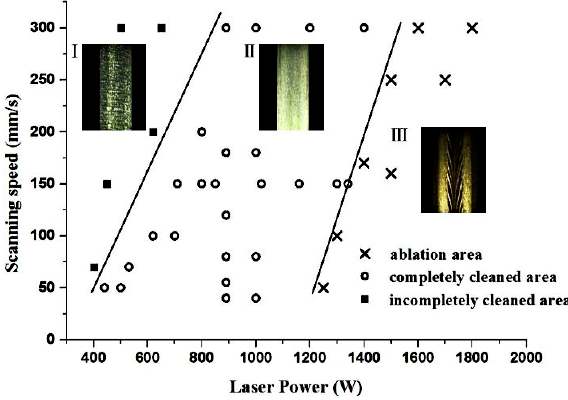
Figure 5. Process window for (inset micrograph: I 300 mm/s, 6.2 W/cm 2 , II 300 mm/s, 11.9 W/cm 2 , III 300 mm/s, 19.1 W/cm 2 ).